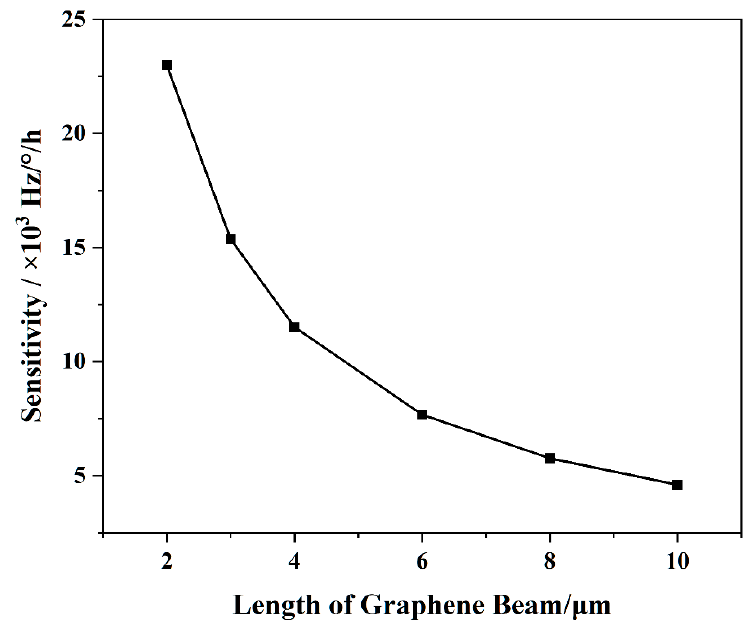
Figure 9. Sensitivity versus length of the graphene resonant beam.